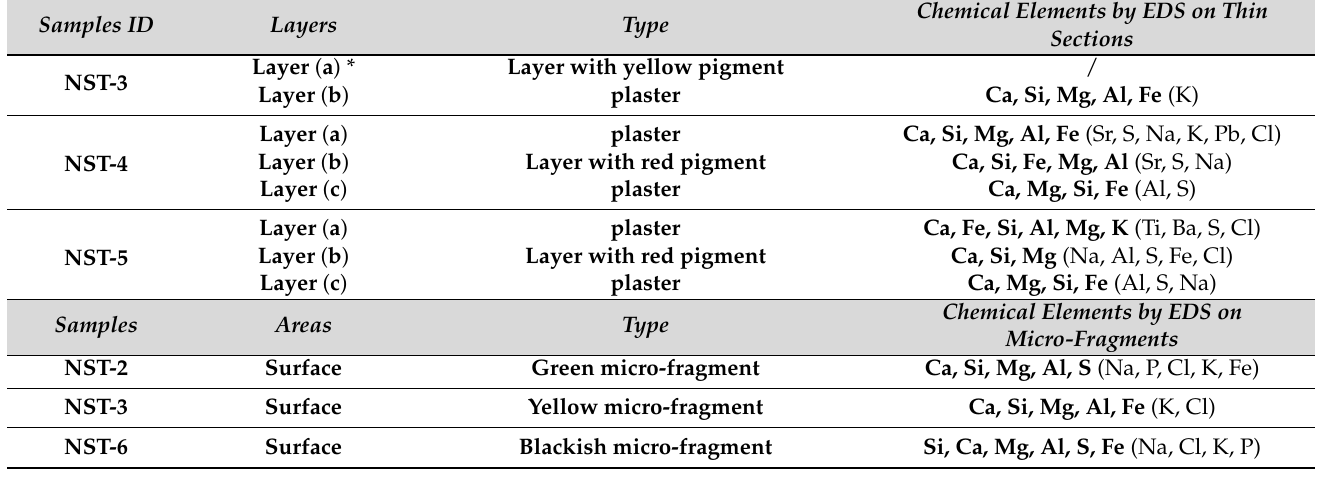
Table 3. EDS chemical data detected for both thin sections and micro-fragments of “Virgin” mural painting. Notes: more abundant elements (in bold); minor elements (in brackets); / (not detected); * the pigmented surface layer of NST-3 was analysed on a micro-fragment.